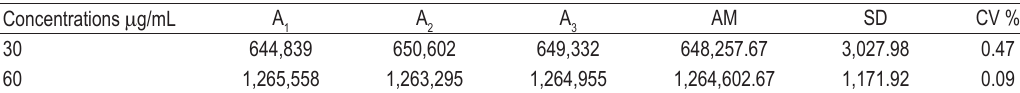
TABLE 4. Repeatability after 32 h